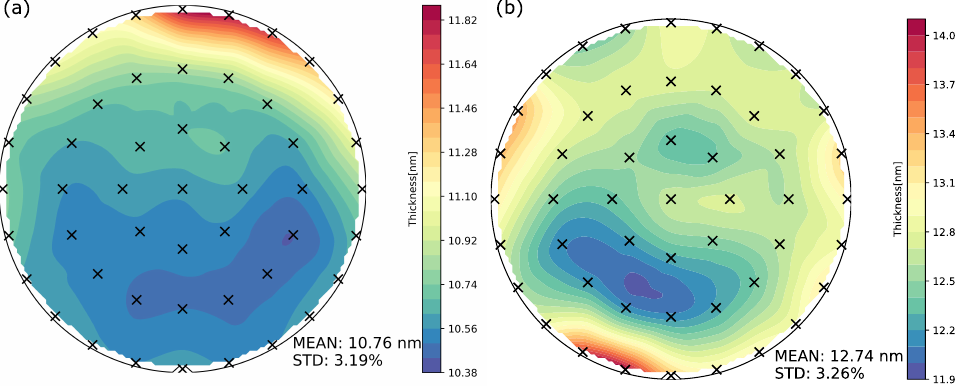
Figure 1. The Wafer maps of HSO thin films deposited by ( a ) the standard ALD process and ( b ) the hybrid ALD process demonstrated different patterns of film